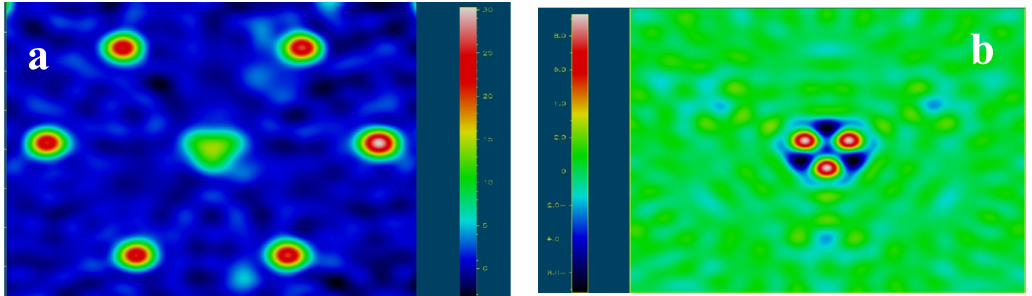
Figure 12. Sample 2: Electron density at O(1). The high displacement parameters and oblate behaviour of the O(1) anion site in the three samples are related to the trilobated shape of the maxima at that position. This is ascribable to local static disorder due to the presence of three different size cations as Al < Li < Mn 2+ in the three Y coordinating sites for every O(1) anion site. ( a ) is a F o Fourier